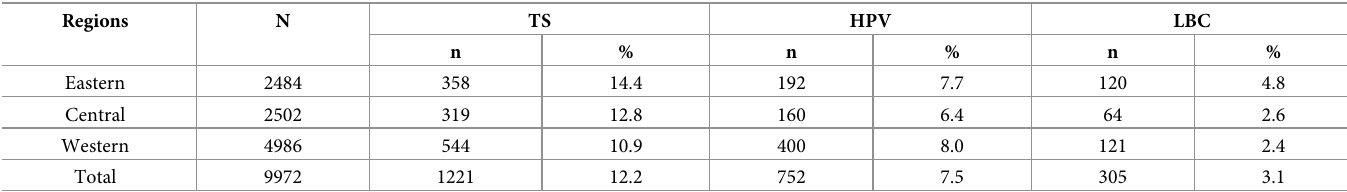
Table 1. Positive results of TS, HPV and LBC screening indifferent regions of China, 2018. Regions